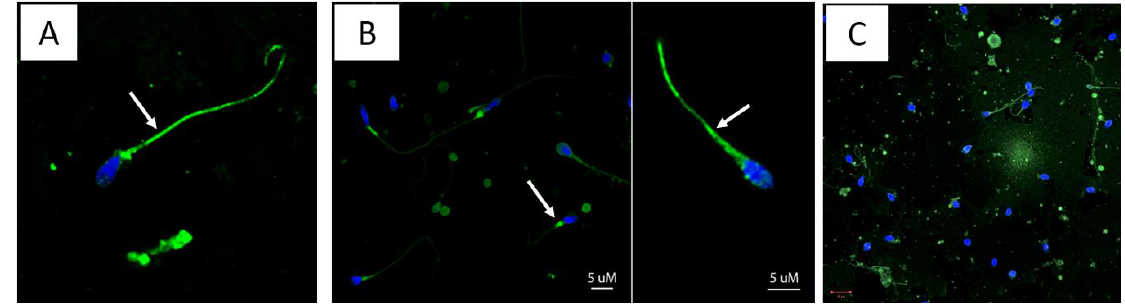
Figure 2. Immunofluorescent patterns. Slides with IF-positive (green) re-examined with confocal microscopy. Figures in this panels shows that Flavivirus antigens (green, Alexa 488) binds to sperm cells, with high affinity to the tail ( A , B ) and the neck ( B ) of the sperm, as pointed out by white arrows. Green spots were also observed in the head of some sperms as shown in C (center). Pictures were captured using confocal microscopy (LSM700 Zeiss, Oberkochen, Germany). All images were taken with 63× objective.